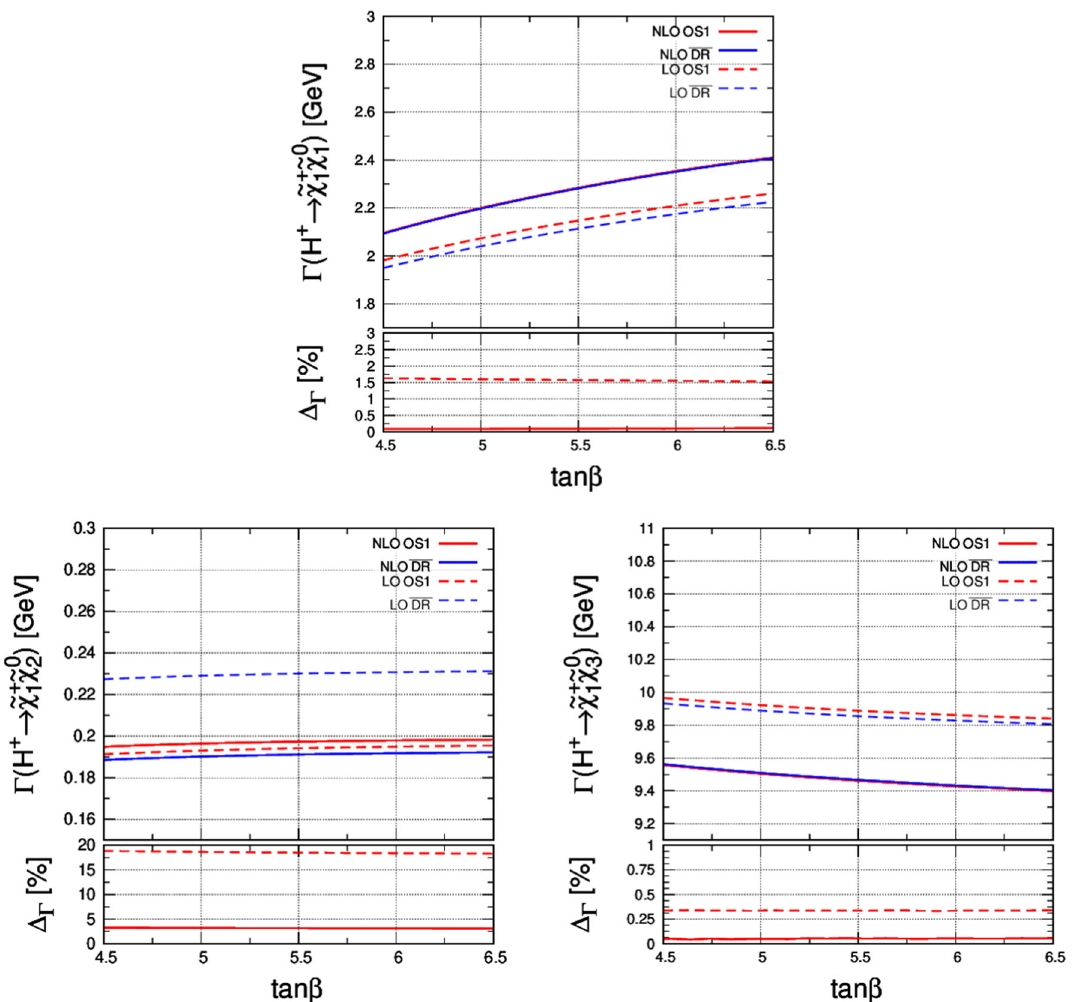
Fig. 9 The partial decay width for the decays of H + into the elec- troweakino final states ˜ χ +